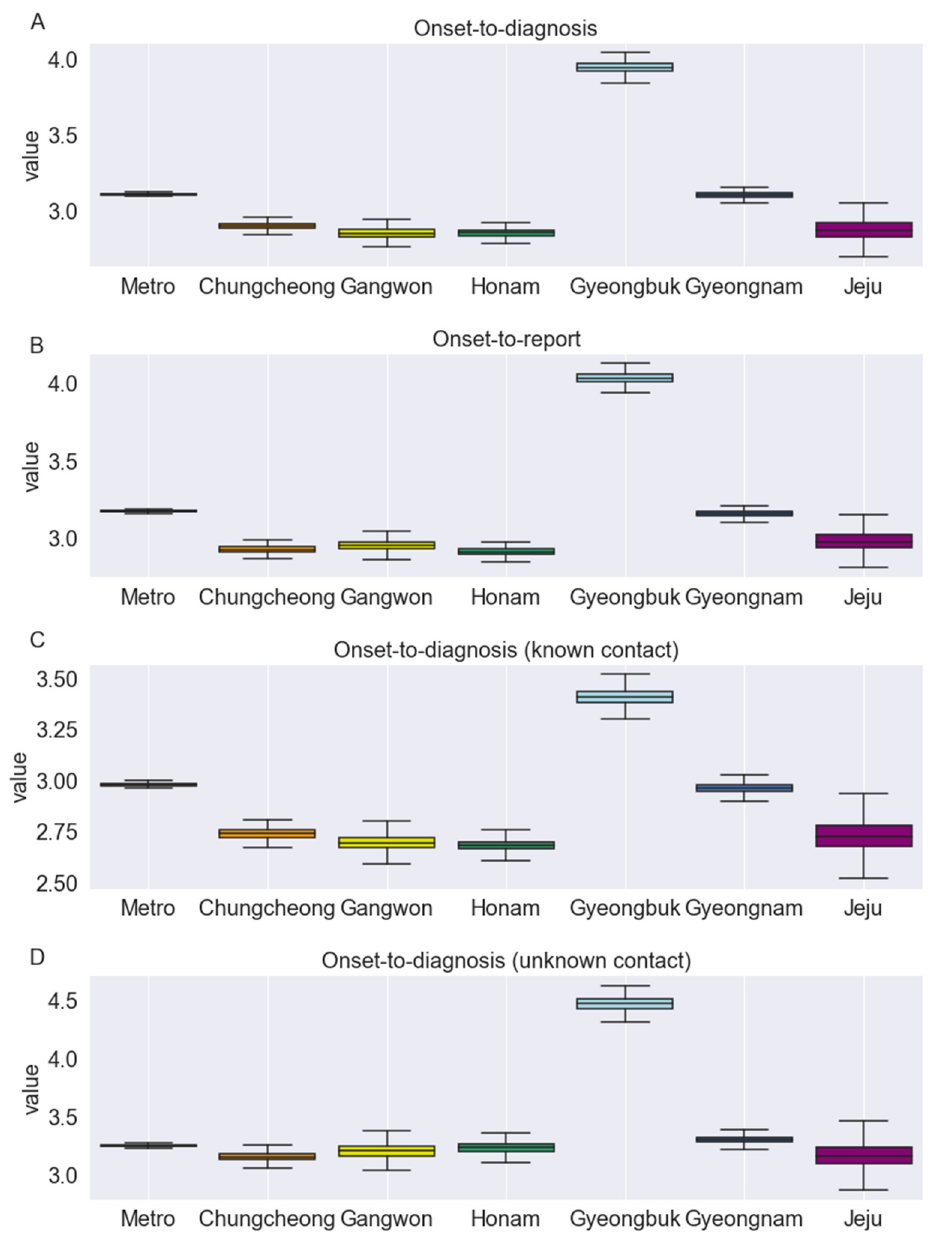
Figure 3. Region-specific estimates of the mean interval (in days) for: ( A ), onset-to-diagnosis (all cases considered); ( B ), onset-to-diagnosis (for cases with known contact); ( C ), onset-to-diagnosis (for cases with unknown contact); and ( D ), onset-to-report distributions fitted in the joint model for the Republic of Korea.